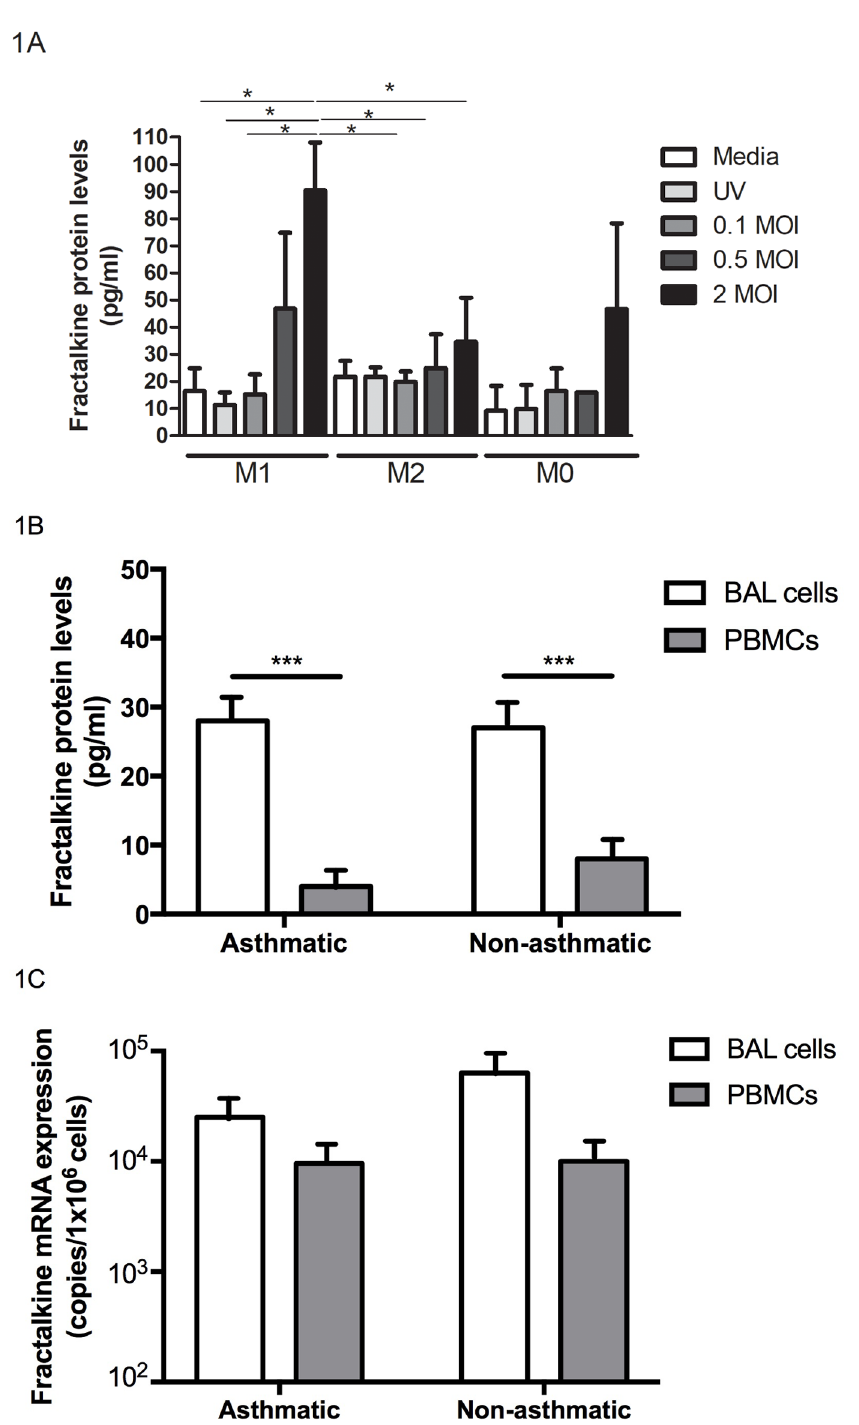
Fig 1. Fractalkine expression in vitro by BAL cells, PBMCs and RV16-infected macrophages. A) Solublefractalkineprotein was measuredin cell supernatants from human peripheral blood monocyte-derived macrophages (M0) and M1 and M2 polarizedmacrophages (n = 3) followingin vitro RV16 infection(0.1–2 MOI) or control conditions(Media, UK-inactivated RV16). B) Solublefractalkine protein was measured in PBMC (grey columns) and BAL (white columns) cell supernatants obtainedfrom asthmatic (n = 15) and non- asthmatic (n = 15) subjects following8h incubation in RPMI medium. C) Gene expression(mRNA levels) was measuredin cDNA from PBMC and BAL cells from each subject. All data are expressedas mean ± SEM. Data were analysedby one-wayANOVA with Bonferroni post-test ( * P < 0.05, *** P < 0.001).